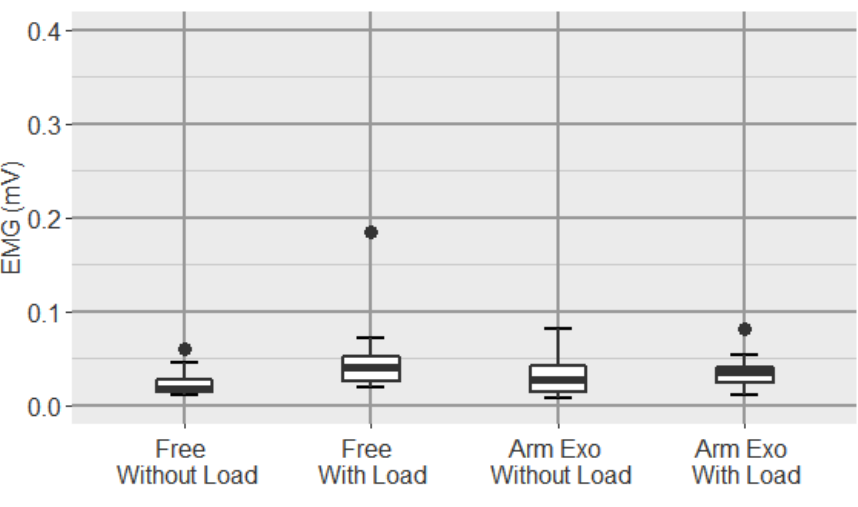
Figure 12. Boxplot of the EMG signal of the triceps brachii for all